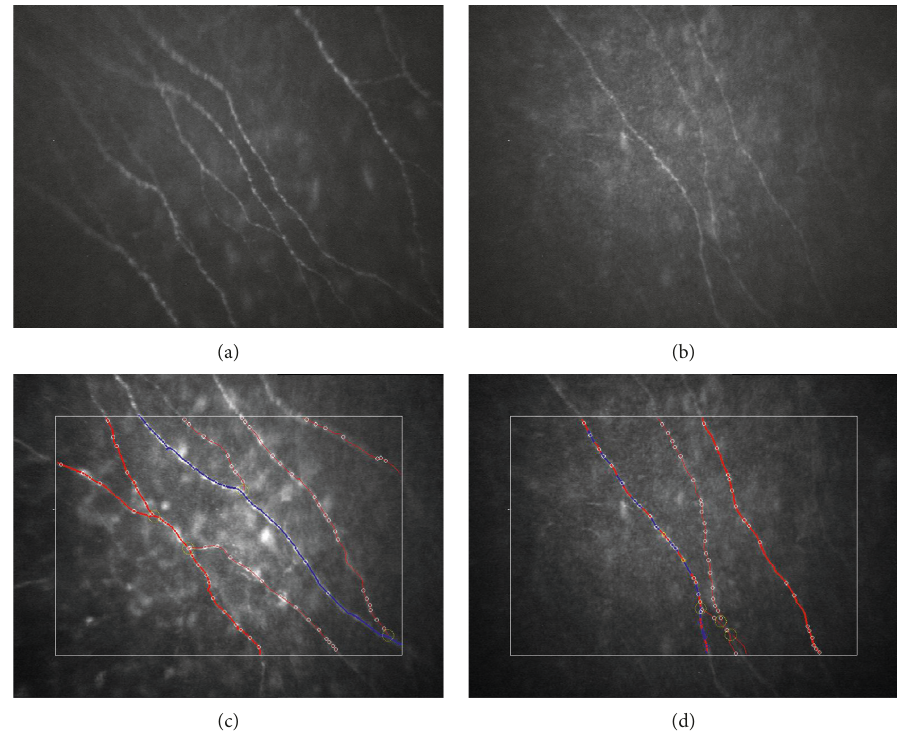
Figure 1: Representative IVCCM images of (a) a healthy control; (b) a T1DM patient with no DPN; (c) corneal nerve fiber image analysis using CS4 Nerves Tracking software of a healthy control; (d) corneal nerve fiber image analysis using CS4 Nerves Tracking software of a T1DM